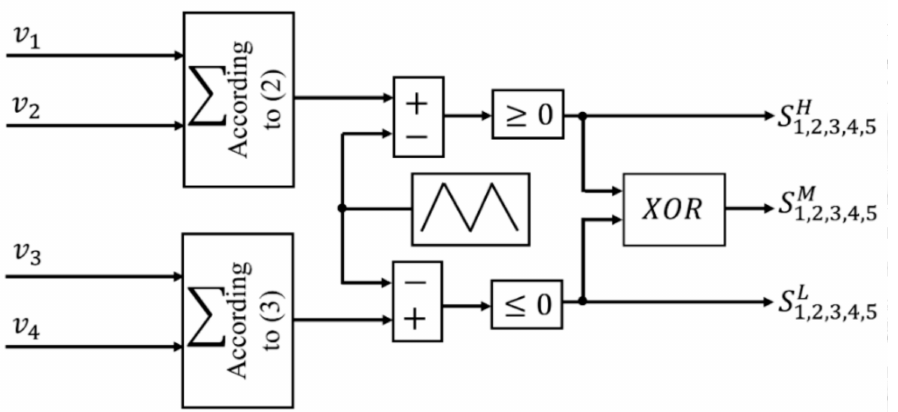
Figure 3. Generalized PWM